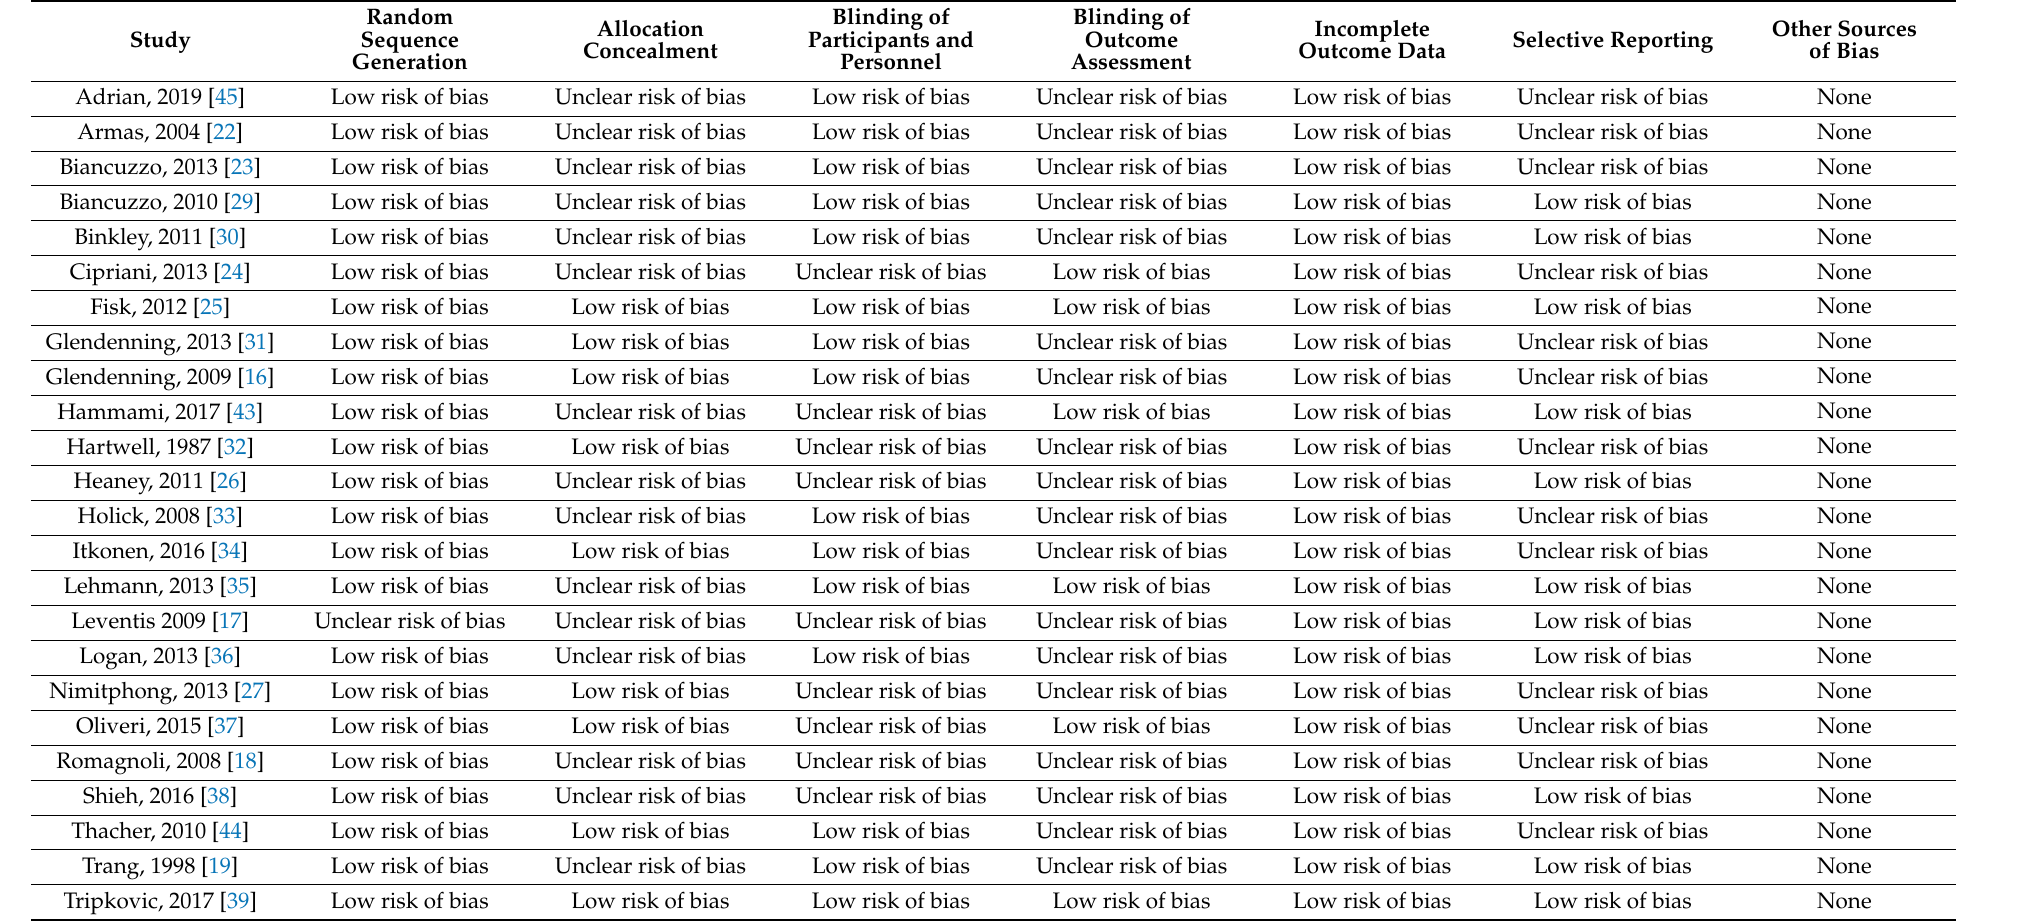
Table 2. Risk of bias